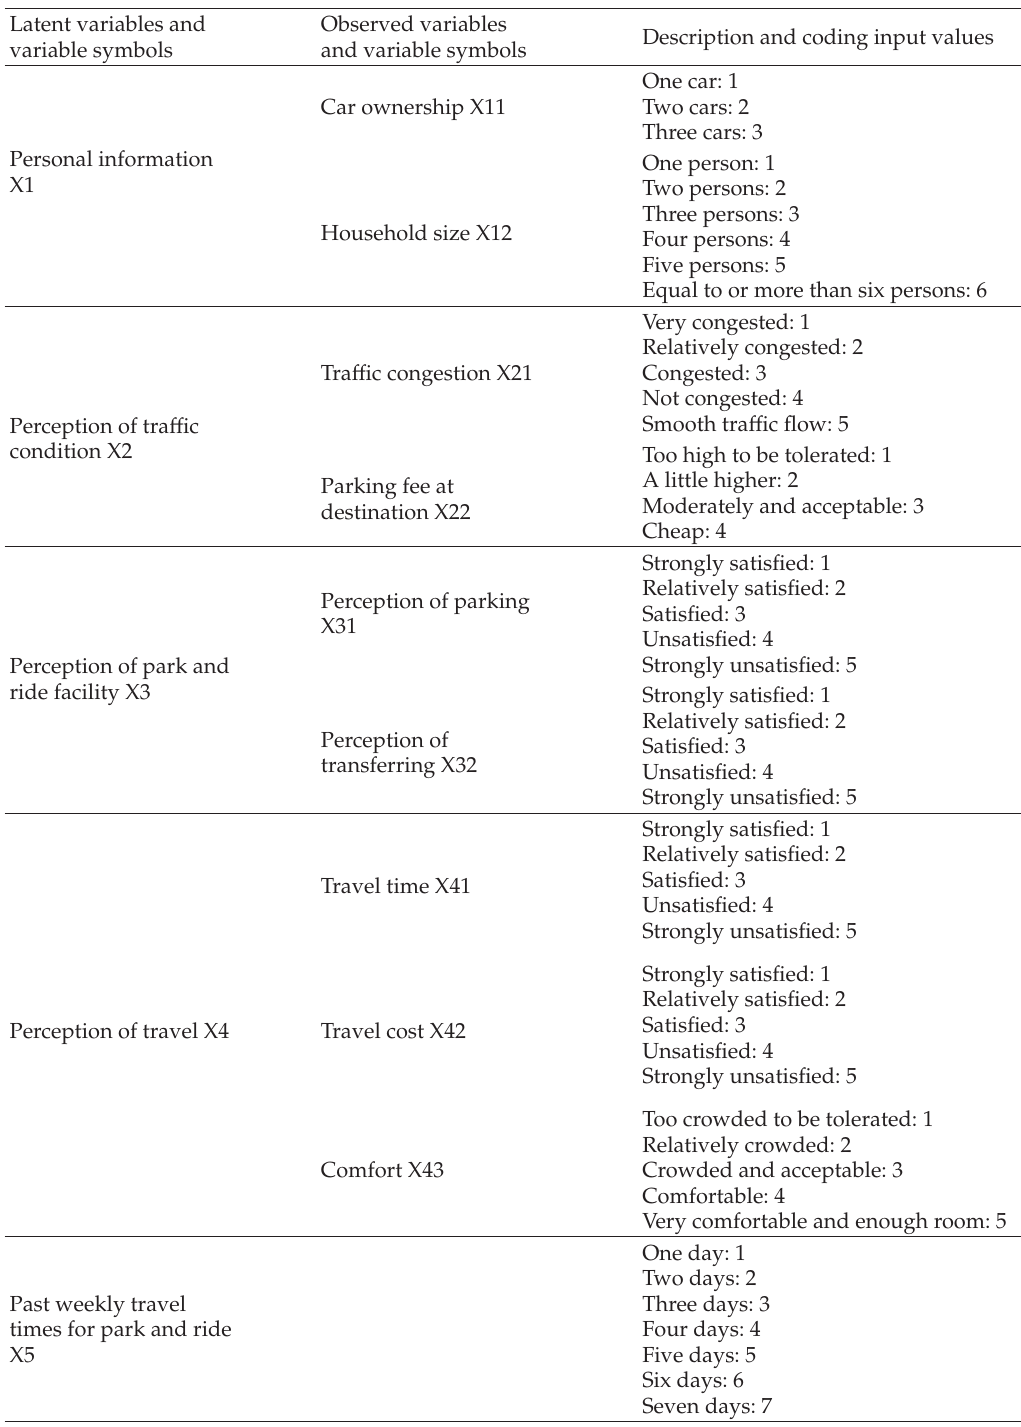
Table 1: Variables in structure